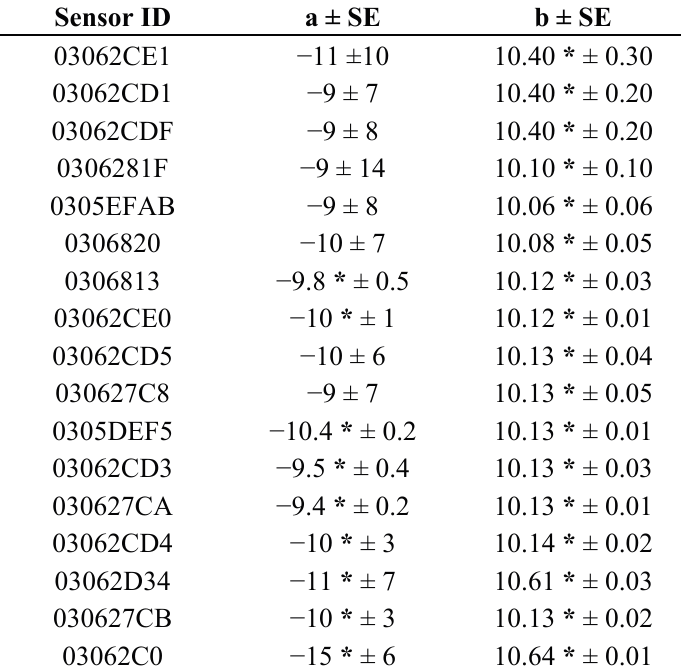
Table 2. Laboratory two-points individual calibration equations for the NDIR sensors raw data (mV) against CO 2 concentration ([CO 2 ], ppm v ), for the linear model of the form [CO 2 ] = a + b